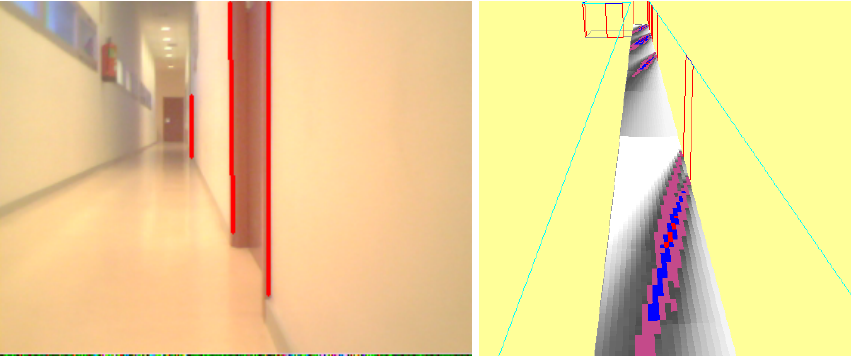
Figure 23. Observed image (left) and probabilities calculated with theta equals to 0 radians(right).